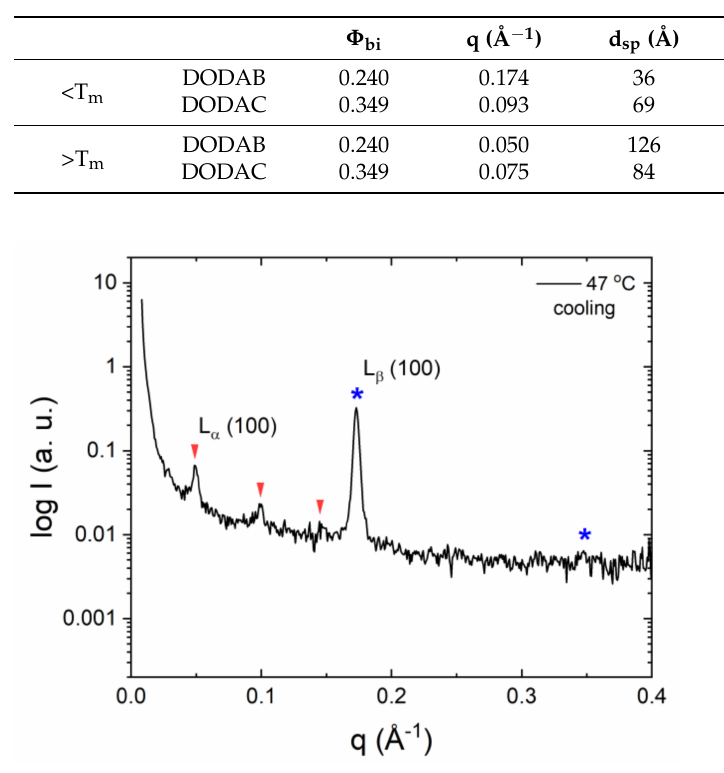
Figure 5. Small- and wide-angle X-ray scattering characterisation of 25 wt% DODAB in water. ( a ) 2D image and correspond- ing ( b , c ) 1D SAXS patterns and ( d ) 2D image and corresponding ( e , f ) 1D WAXS patterns during a heating and cooling ramp from 40 to 58 ◦ C and back to 35 ◦ C. Table 3. Calculated values of the bilayer volume fraction ( Φ bi ), bilayer thickness (d bi ) and area per surfactant molecule (a) of the 25 wt% of the DODAB and 35 wt% of the DODAC bilayers in water at temperatures below and above the main phase transition temperature (T m ).